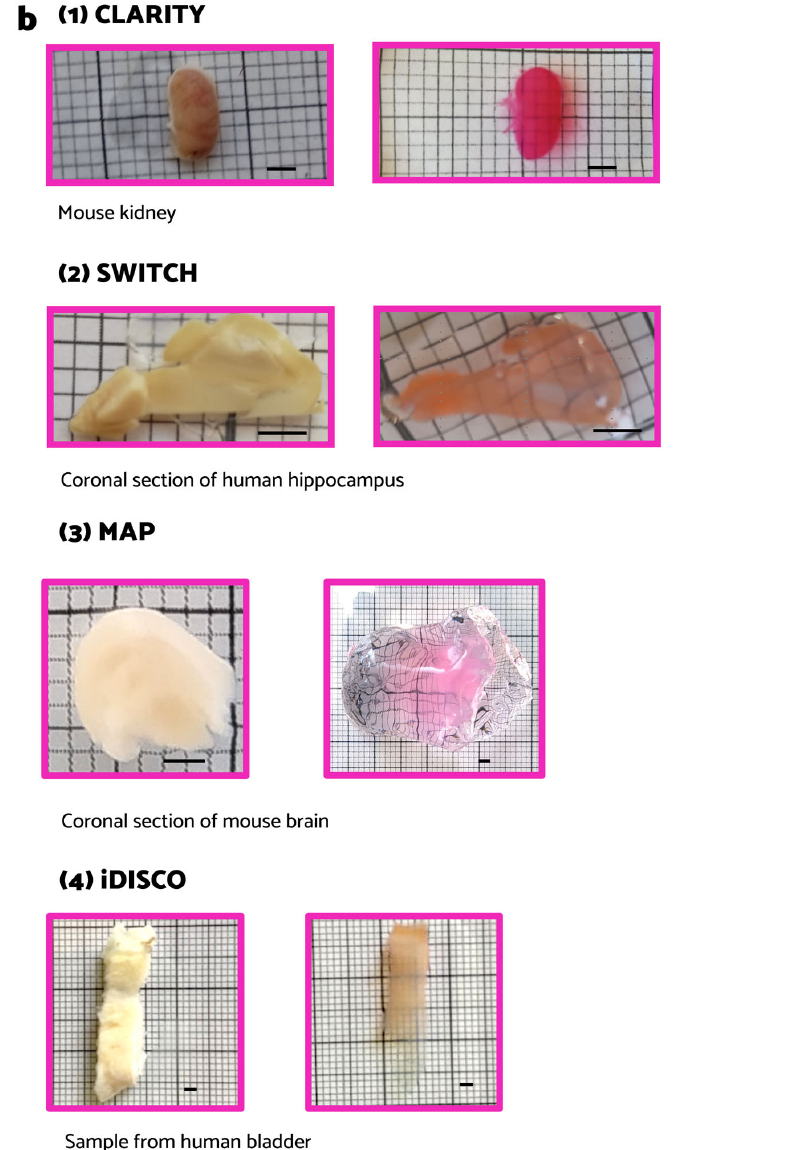
Figure 1. Tissue transformation and experimental pipeline. ( a ) Graphical abstract of the developed experimental pipeline which is composed of clearing, staining, imaging, and post-processing (image created with BioRender.com). ( b ) Comparison of clearing techniques applied to different biological samples before and after staining. (1) Mouse kidney before (left) and after (right) hydrogel-tissue transformation with CLARITY technique, staining, and thiodiethanol (TDE) refractive index (RI) matching. (2) Coronal section of human hippocampus before (left) and after (right) tissue transforma- tion with SWITCH technique, staining, and TDE RI matching. (3) Coronal section of mouse brain before (left) and after (right) hydrogel-tissue transformation, staining, and expansion using MAP protocol. (4) Human bladder before (left) and after (right) clearing using iDISCO